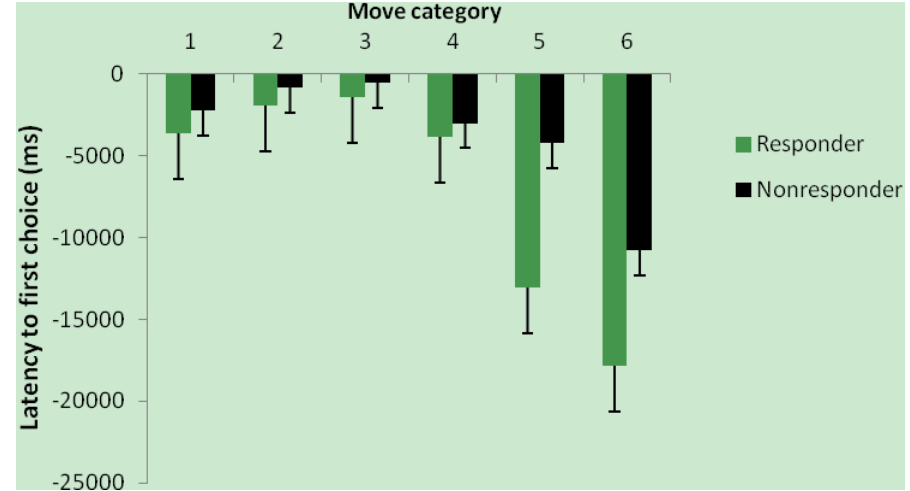
Figure 2. Change in response time by ferritin response group; Change (endpoint-baseline) in One-Touch Stockings of Cambridge latency to first choice for move categories 1–6 for ferritin responders ( n = 17) and non-responders ( n = 26). Main effect of responder group, p =